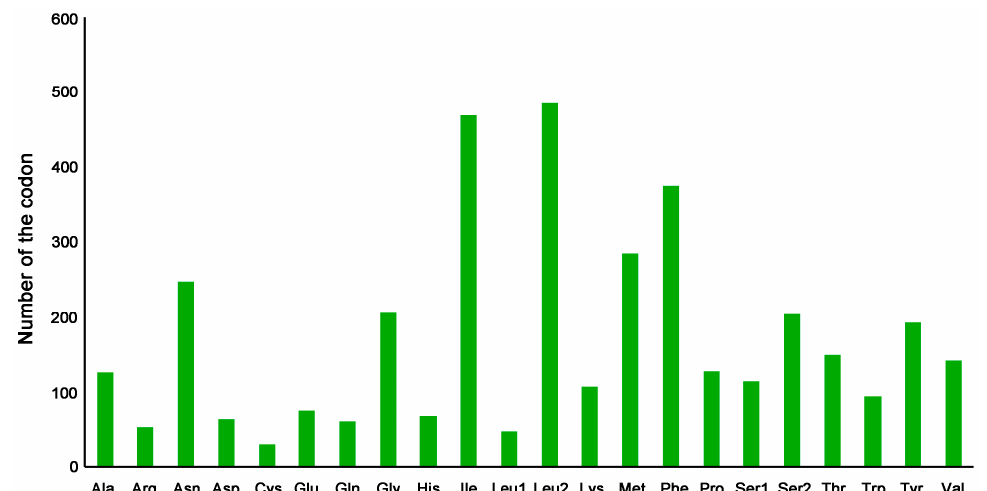
Figure 2. The relative synonymous codon usage (RSCU) in the mitogenome of C. perspectalis .